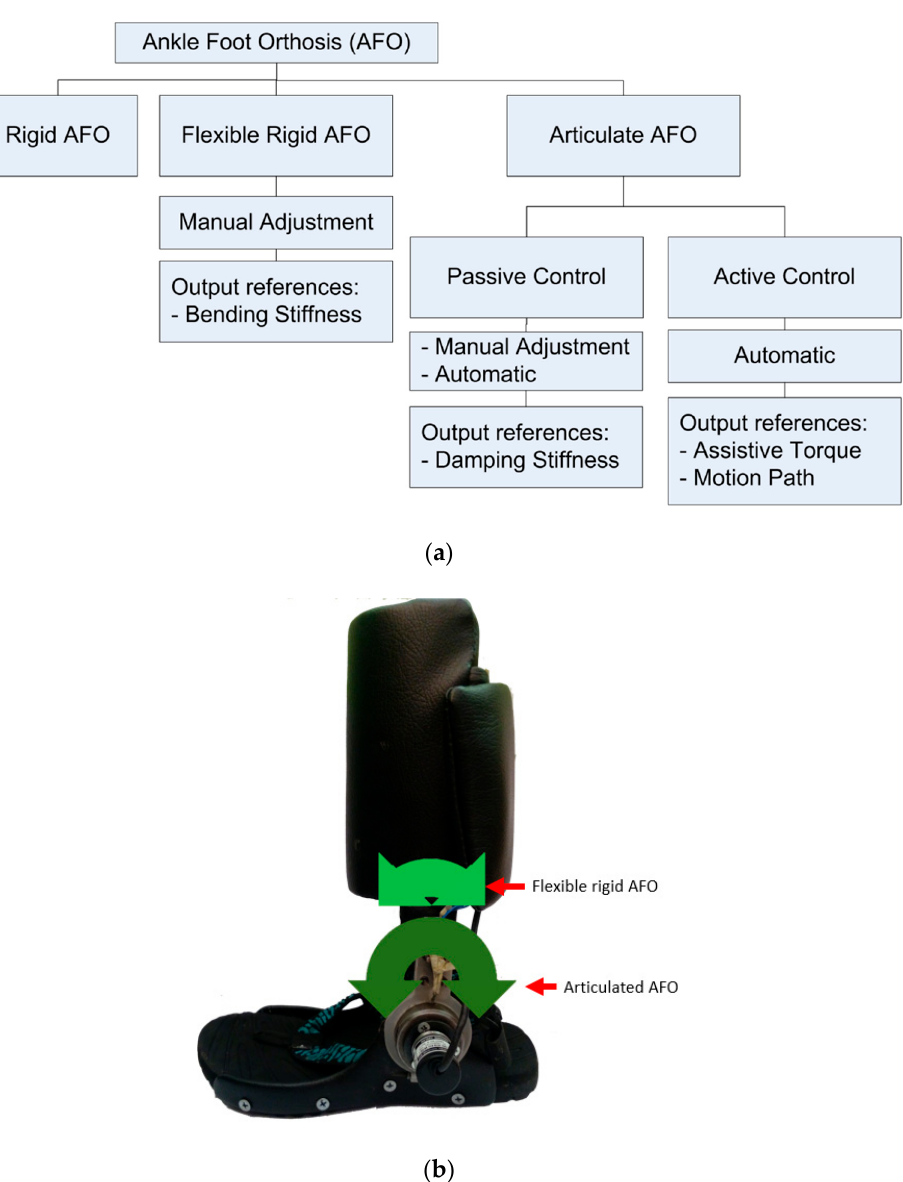
Figure 3. Hierarchical structure of Ankle Foot Orthosis (AFO) ( a ) and illustration of the AFO structure ( b ). Rigid, flexible rigid, and articulate AFO. The rigid AFO has no rotational movement; the flexible rigid AFO has a limited angle of rotation, and the articulated AFO has the largest angle of rotational movement of up to 360°